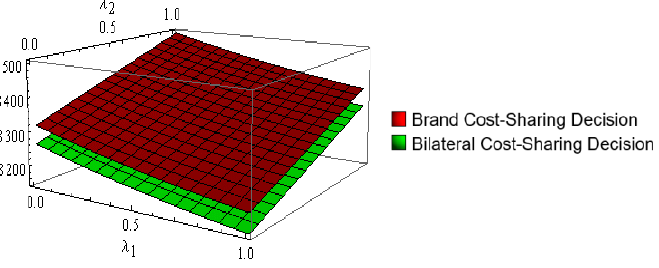
Figure 8. Impact of λ i on the Brand Owner’s Profit When P 1 > P ∗ .